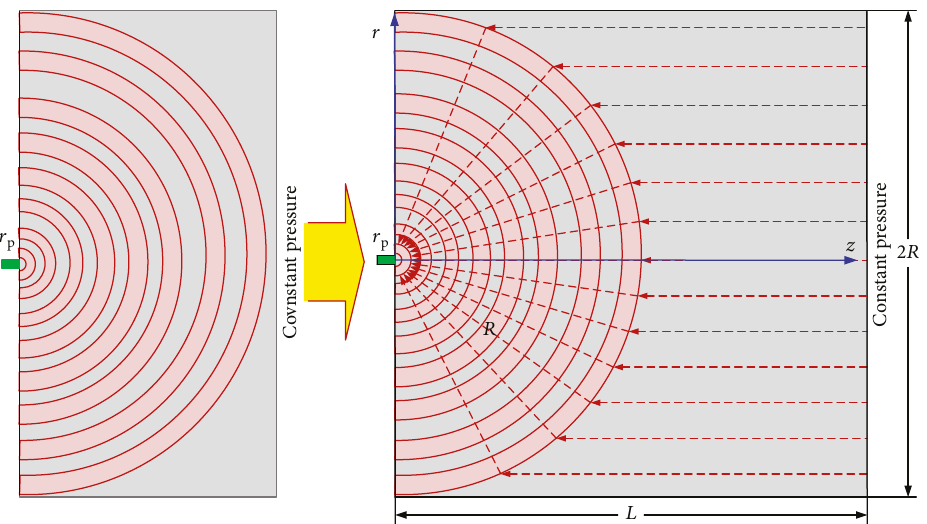
Figure 5: Streamlines in a fi nite physical simulation sample.